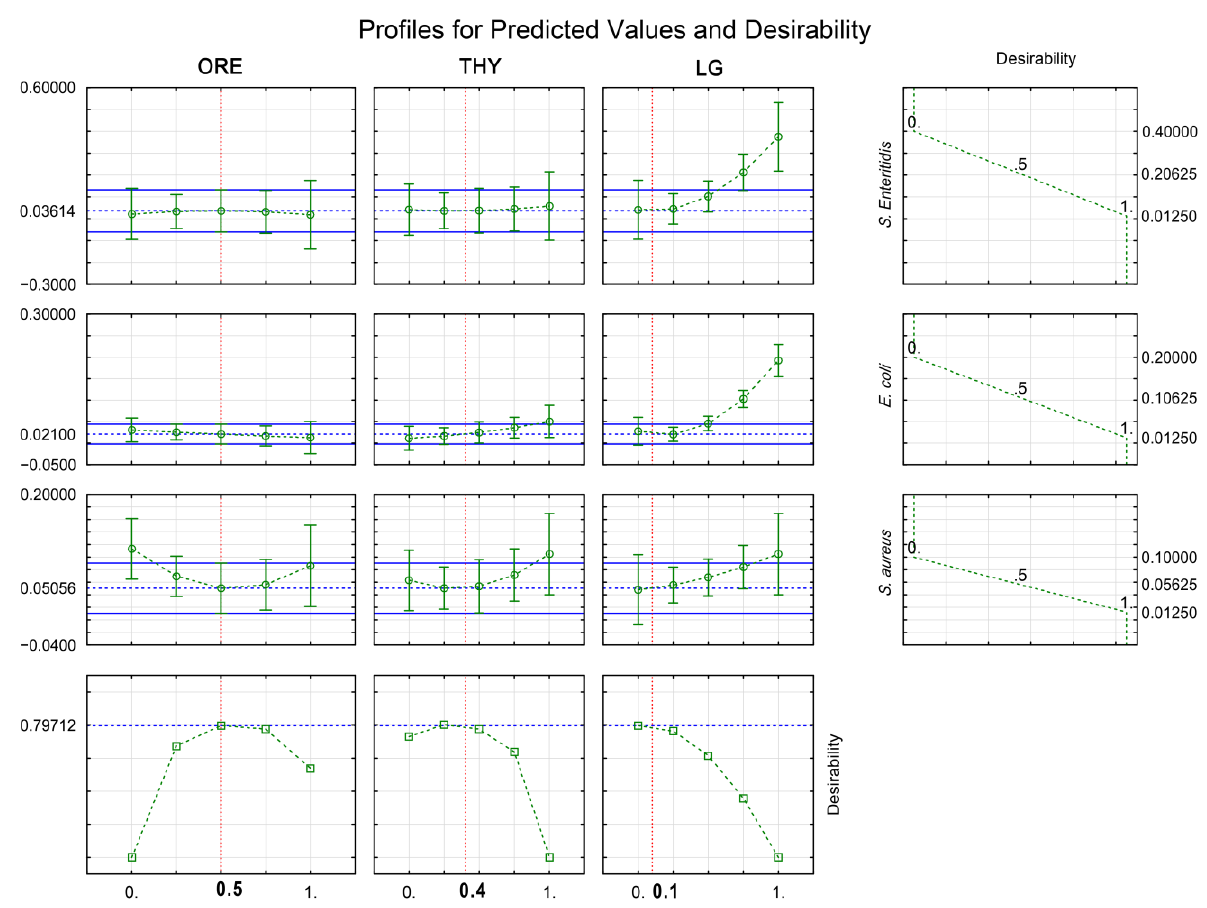
Figure 3. Desirability plot showing the optimal proportions of oregano (ORE; Origanum vulgare ), thyme (THY; Thymus vulgaris ), and lemongrass (LG; Cymbopogon citratus ) to simultaneous inactivation (MBC) of Escherichia coli , Salmonella enterica serotype Enteritidis, and Staphylococcus aureus . Results are expressed in percentage (%) and are from twelve experiments, including three central replicates (Section 5.3). Table 3. Observed values and validation for the optimal mixture of oregano (ORE; Origanum vulgare ), thyme (THY; Thymus vulgaris ), and lemongrass (LG; Cymbopogon citratus ) essential oils (EOs) against Escherichia coli , Staphylococcus aureus , and Salmonella enterica serotype Enteritidis considering minimum inhibitory concentration (MIC) and minimum bactericidal concentration (MBC) values.